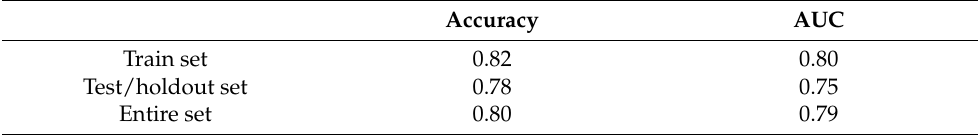
Figure 8. DT model accuracy and AUC vs. number of nodes for both the train and test/holdout datasets. Table 5. The 21-node DT model performance metrics for the train and test/holdout datasets.